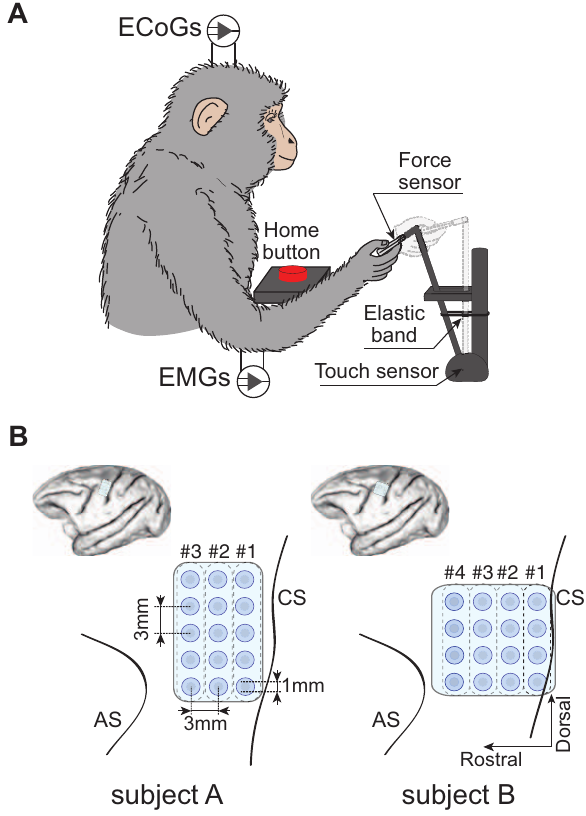
Figure 1. Behavioral task and ECoG electrode locations. A) Monkeys performed sequential right arm and hand movements, which consisted of reaching to a knob, grasping the knob with a lateral grip, pulling the knob closer, releasing the knob, and returning the hand to the home position, in a 3-D workspace. During the task, ECoG and EMG signals were recorded simultaneously. B) Schematic diagrams of ECoG electrode locations in left hemisphere. The planar-surface platinum electrode arrays were placed on the gyrus between the central sulcus (CS) and the arcuate sulcus (AS) in the primary motor area. The # indicates the location according to the column of ECoG